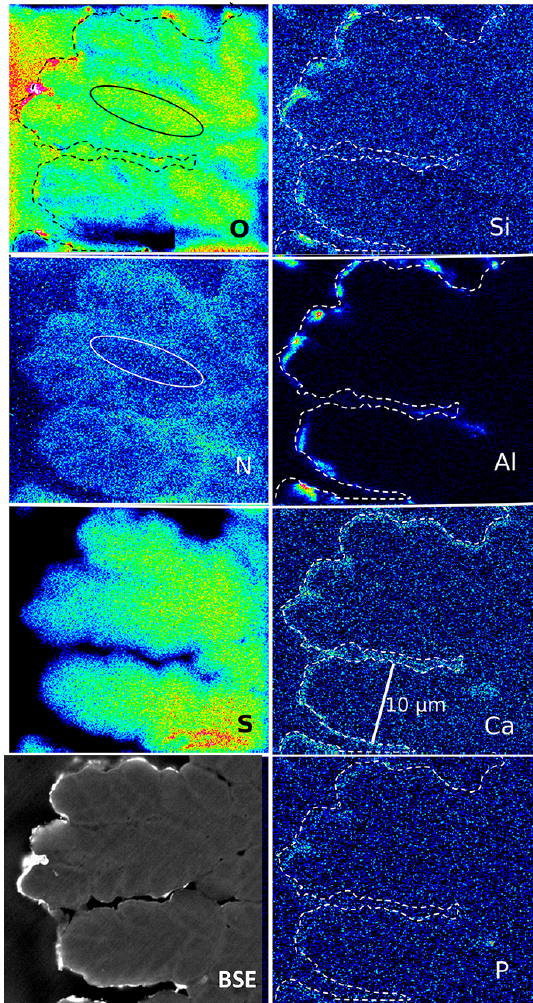
Figure 10. Element distribution (EMPA) in botryoidal kerite. The rim (dashed line) is outlined as seen in the BSE image. Si, Al, and O are concentrated in a discontinuous rim, indicating Al silicates. Ca is concentrated in spots in this rim, together with P, indicating Ca phosphate. Sulfur decreases systematically from the central part to the rim. N distribution is heterogeneous and mimics the BSE contrast. Areas rich in O are poor in N (see oval outlined area). Scanning conditions: pixel resolution of 277 × 265 with pixel size of 120nm and a dwell time per pixel of 200ms; total scan area 33 . 2µm × 31 . 8µm.